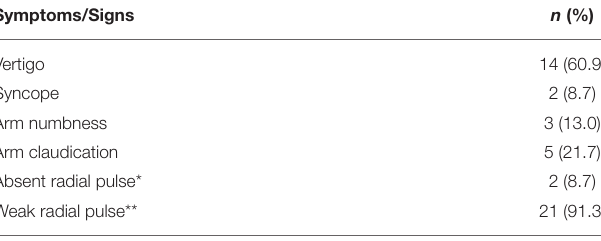
TABLE 2 | Symptoms and signs of the